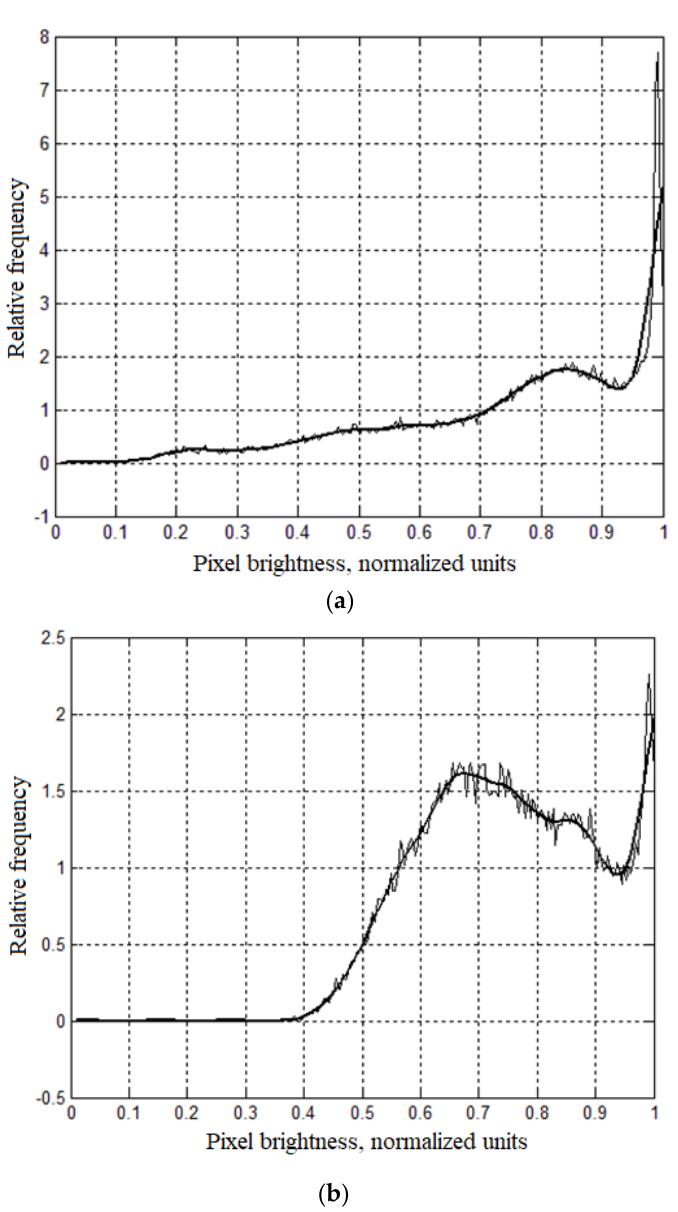
MPIs (Algorithm Step 1.1): ( a )—MPI-1; ( b )—MPI-2.